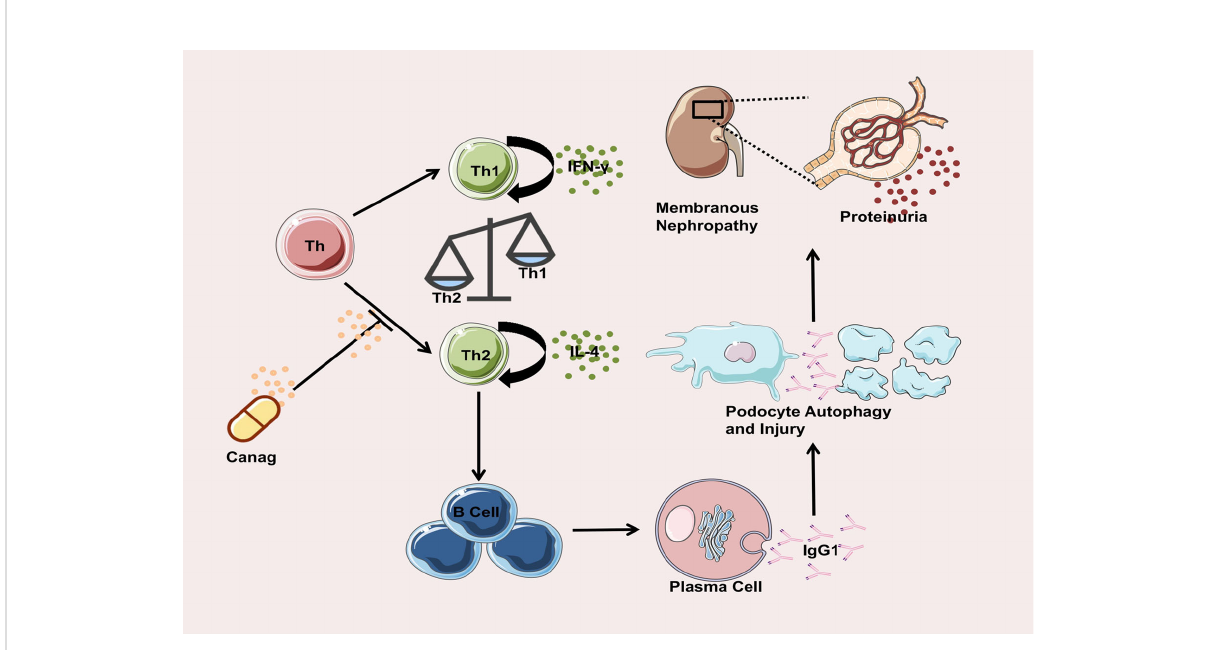
FIGURE 6 Immunomodulatory mechanism of calagli fl ozin in improving renal injury in MN